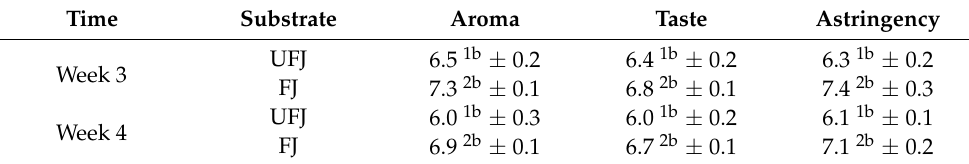
Table 3. Cont. Time Substrate Aroma